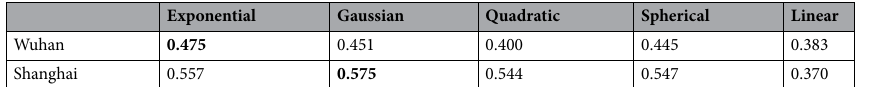
Table 6. The KNN-MI between each SAC variable and dependent variable. Significant values are in bold.